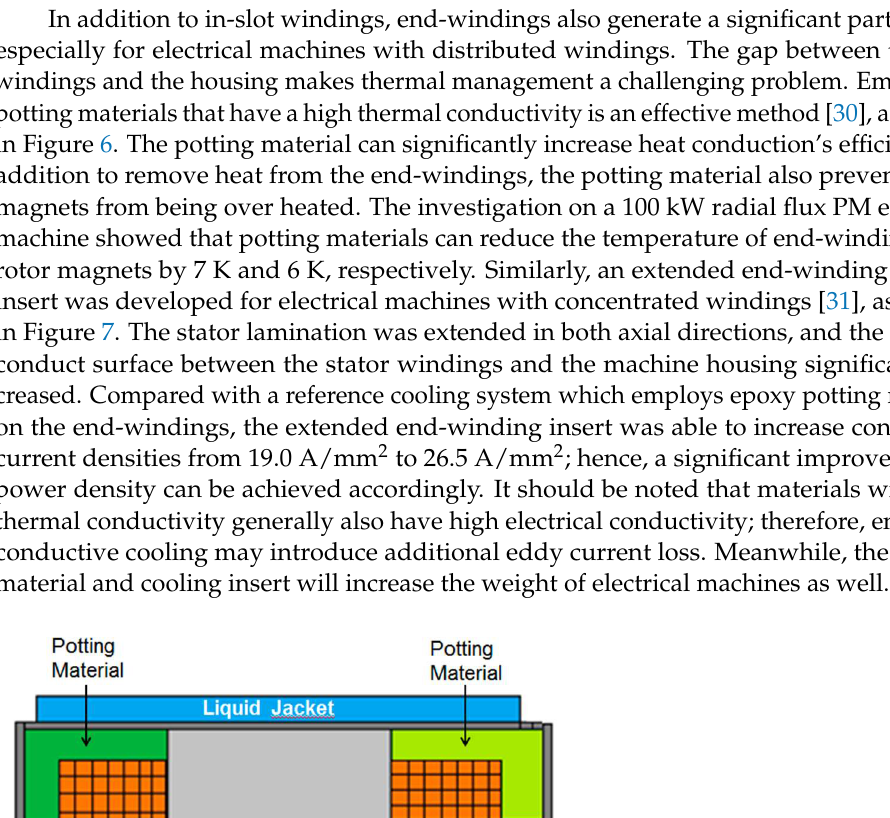
Figure 5. A concentrated winding electrical machine with heat guide [29].